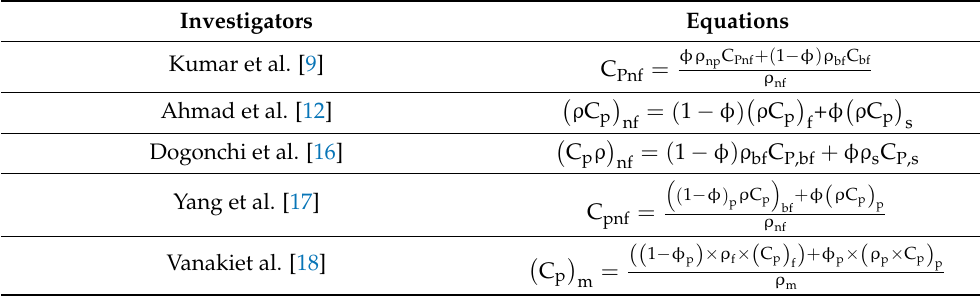
Table 3. Equations used for calculating the specific heat capacity of nanofluids.